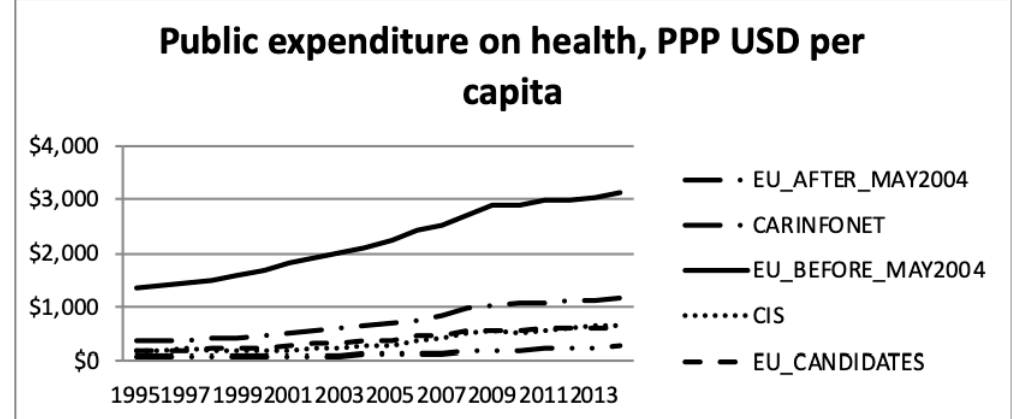
Figure 6. Public health expenditure, purchasing power parity (USD) per capita, the World Health Organisation estimates.